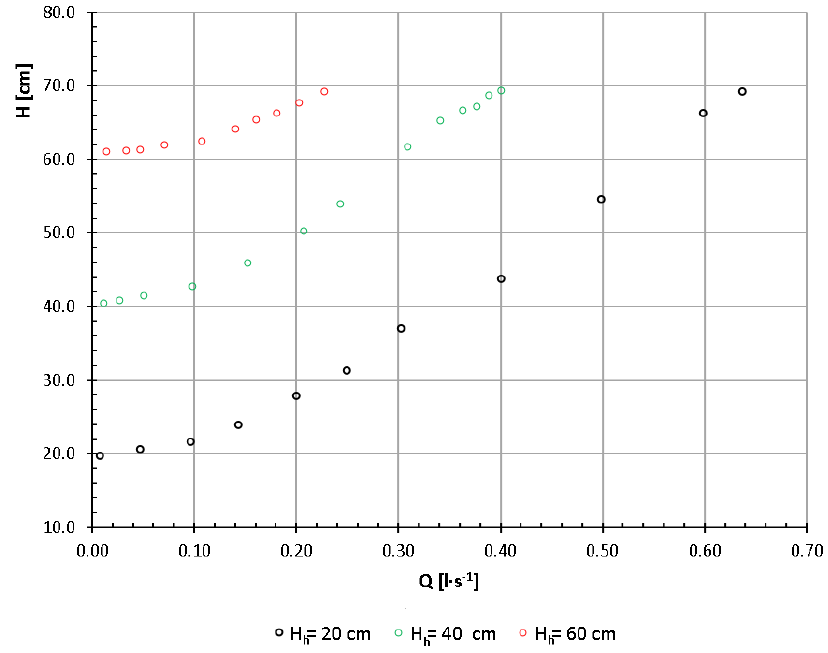
Figure 7. Flow discharge Q curves of the hole regulator for different heights H h of the open hole.